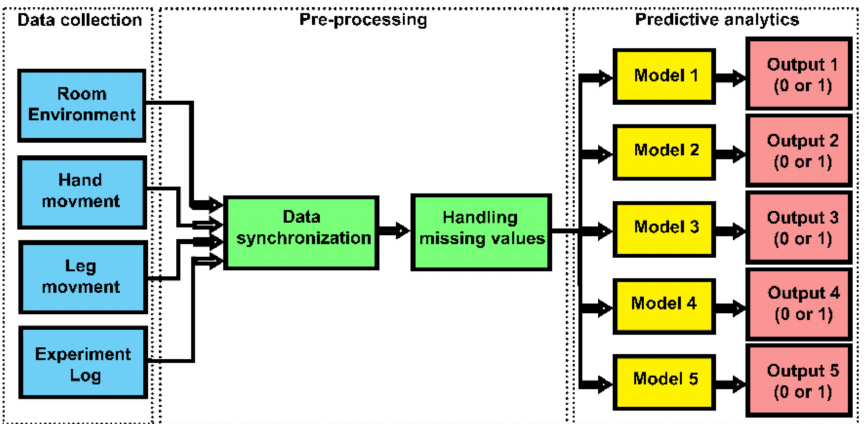
Figure 1. Block diagram of the proposed method using logistic regression.